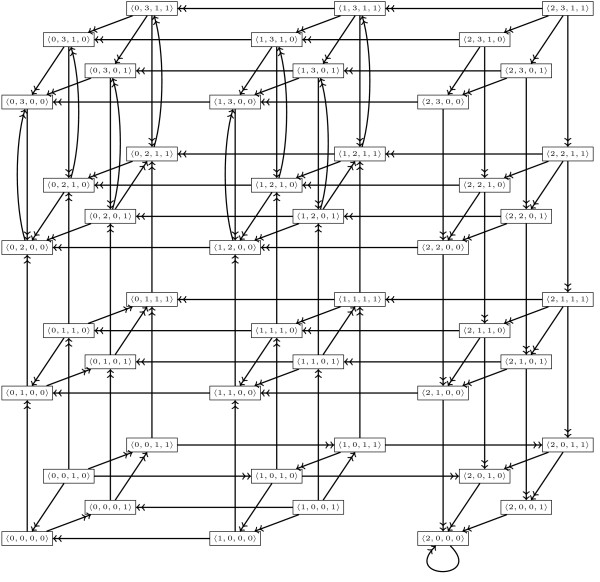
Set of possible transitions for the instantiation of parameters in Example 8 of the model about immunity control by the λ phage.